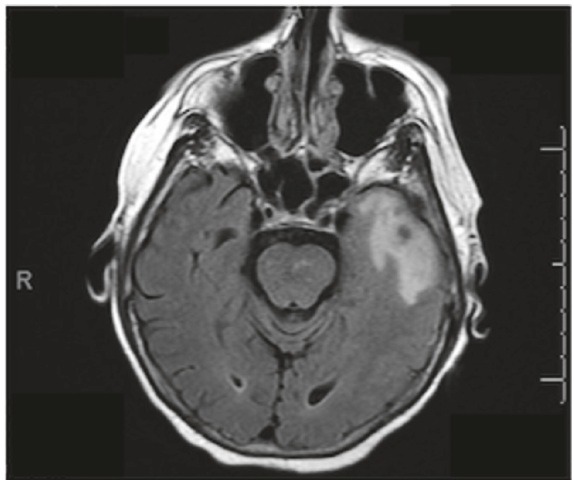
Figure 1: Axial flair MRI showing vasogenic edema of the temporal lobe.